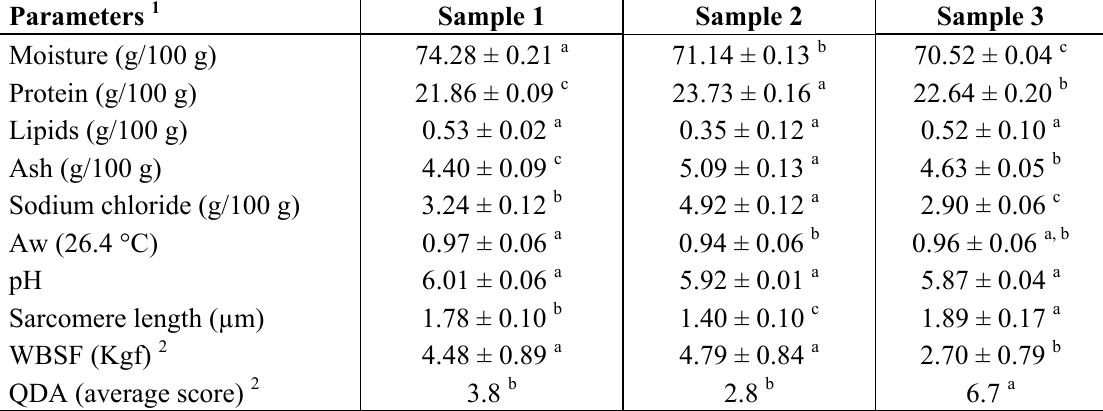
Table 1. Physicochemical qualities and tenderness of the sun-dried